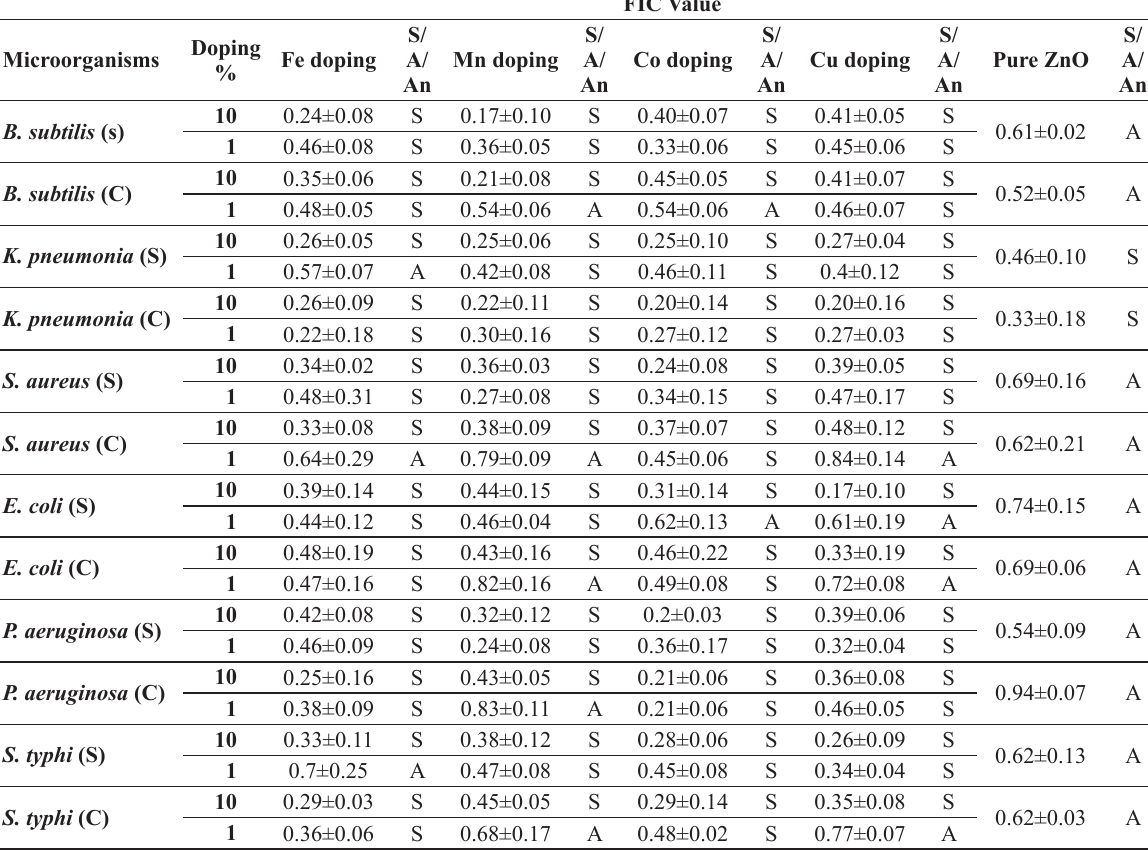
Combined activity of nanoparticles with ciprofloxacin against different pathogenic